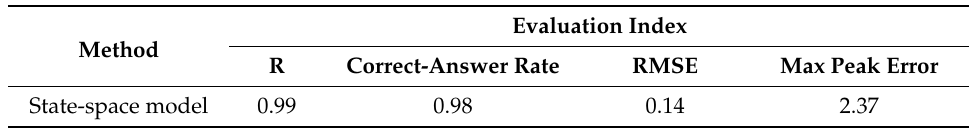
Table 21. Preliminary evaluation indices of rack intake temperature prediction model (8 November 2019 to 20 November 2019; sample number: 961).